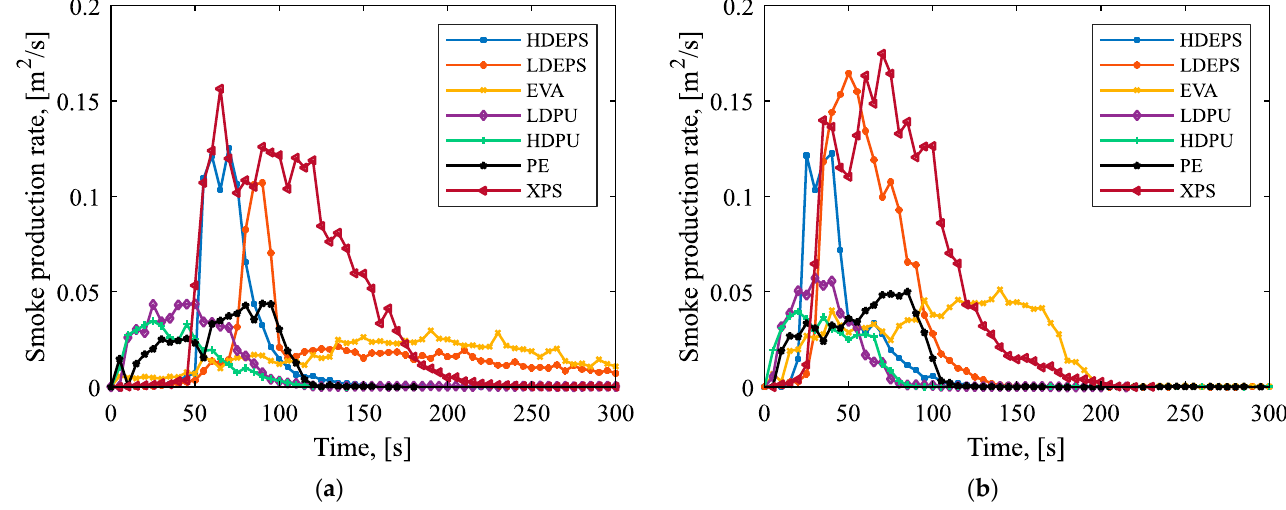
Figure 5. SPR time profile of polymer samples at ( a ) 35 kW/m 2 ; ( b ) 50 kW/m 2 heat fluxes.